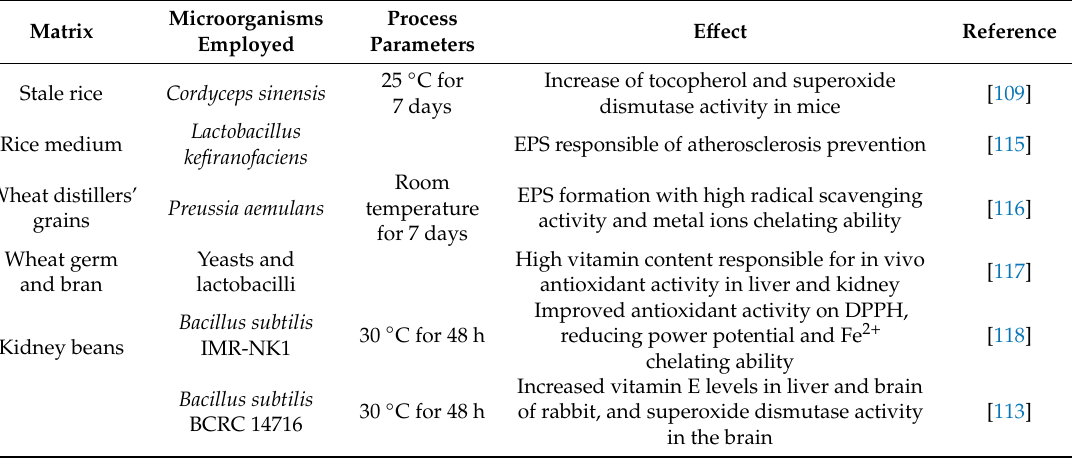
Table 3. Secondary e ff ect of fermentation on the antioxidant activity of cereals and